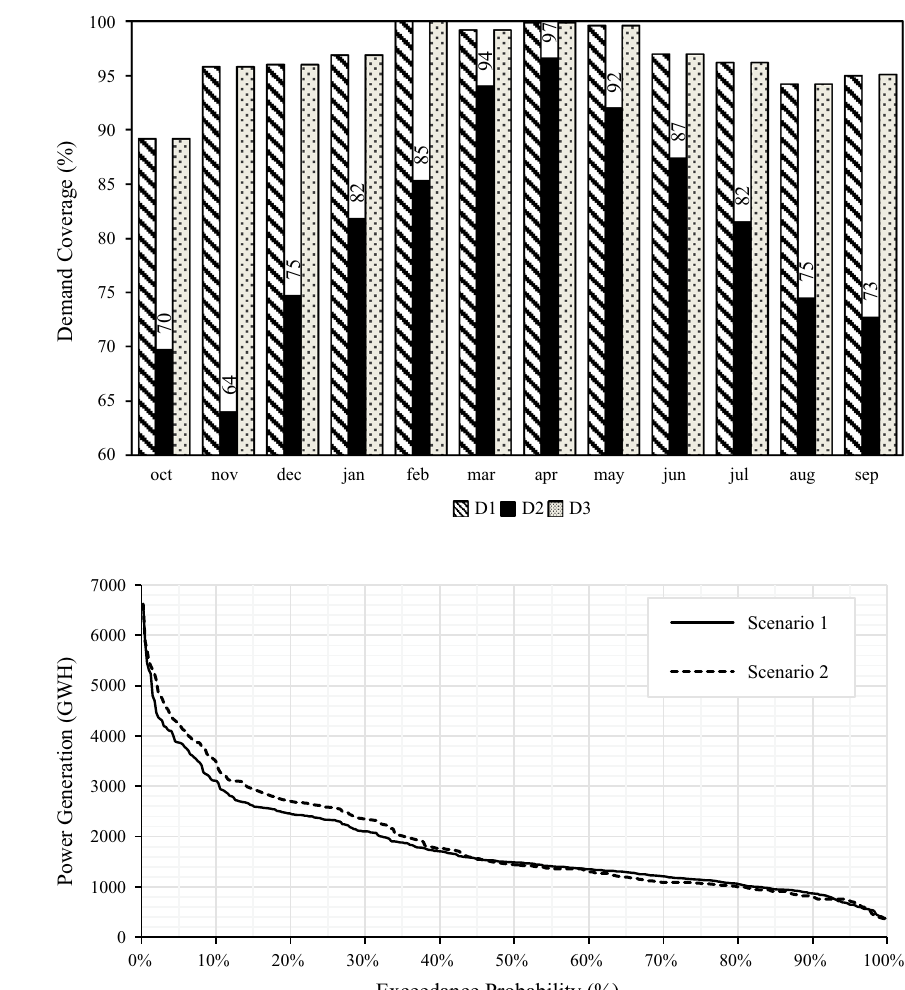
Fig. 5 Energy duration curves for both scenarios